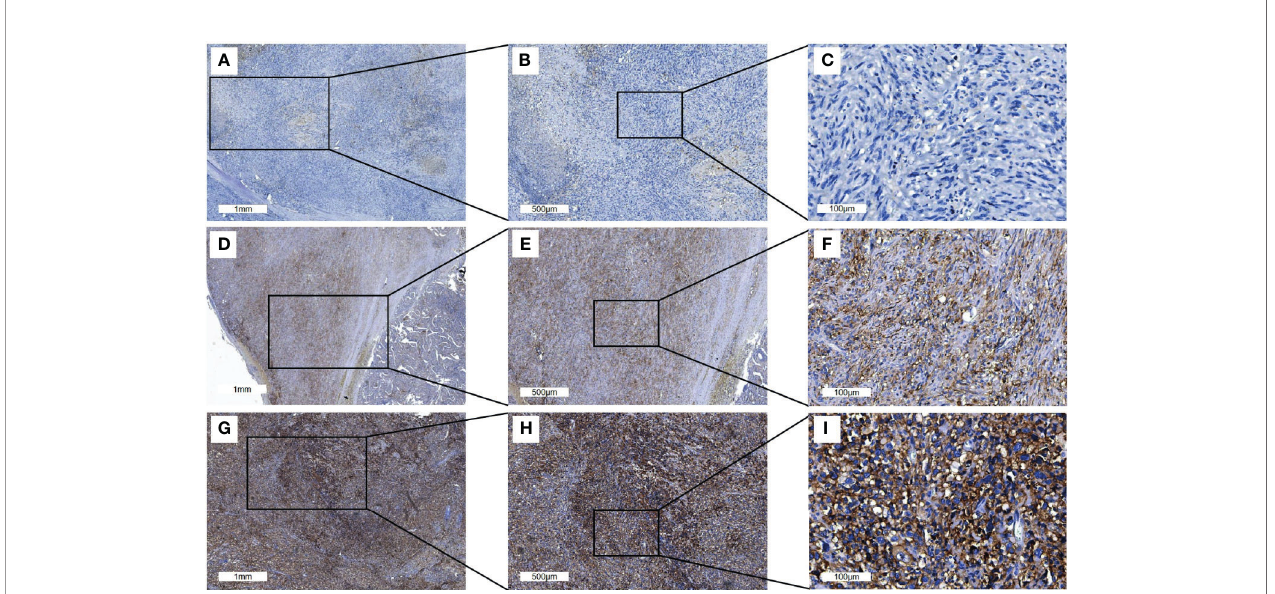
FIGURE 1 | Representative PD-L1 immunohistochemistry staining of full ATC FFPE sections. Three different tissue samples stained with PD-L1 antibody are shown with an overview of the tissue sample ( A, D, G ; scale bars: 1mm), at 2x magni fi cation ( B, E, H ; scale bars: 500 m m) and 10x magni fi cation ( C, F, I ; scale bars: